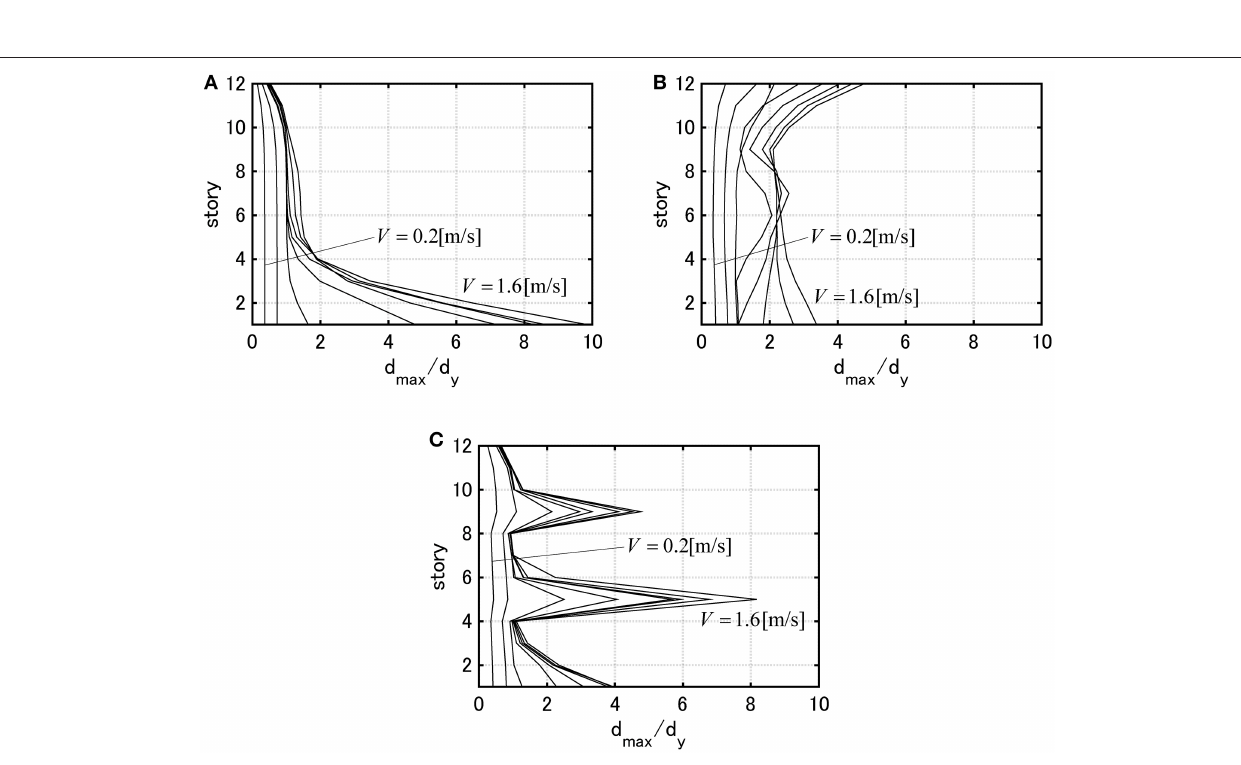
Frontiers in Built Environment |